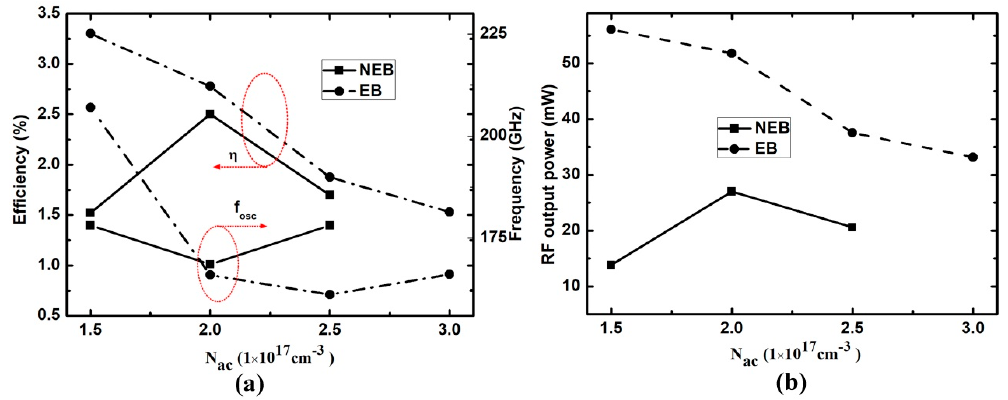
Figure 7. ( a ) Simulation results of the oscillation frequency f osc and dc-to-ac conversion efficiency η versus the doping level N ac and ( b ) RF (Radio Frequency) output power P RF versus N ac under EB and NEB models.